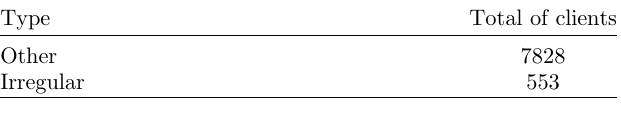
Table 1. Biphasic clients reported by CPFL, period: January, 2011 to June, 2019.